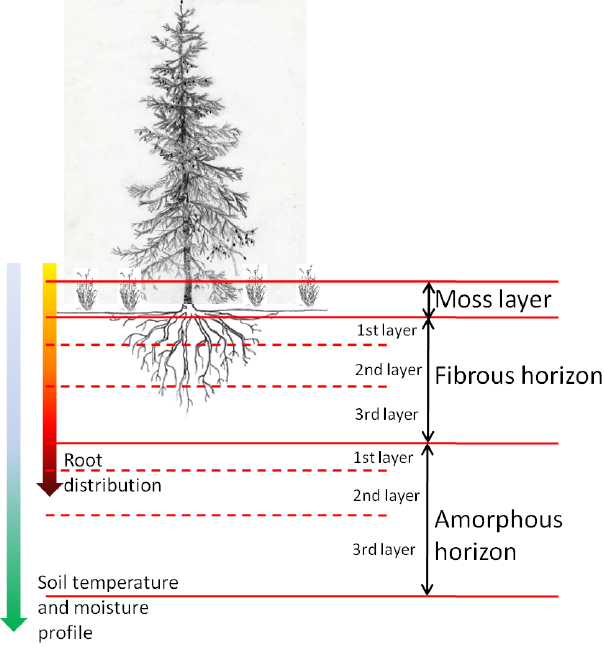
Figure 1. Schematic representation of the soil decomposition